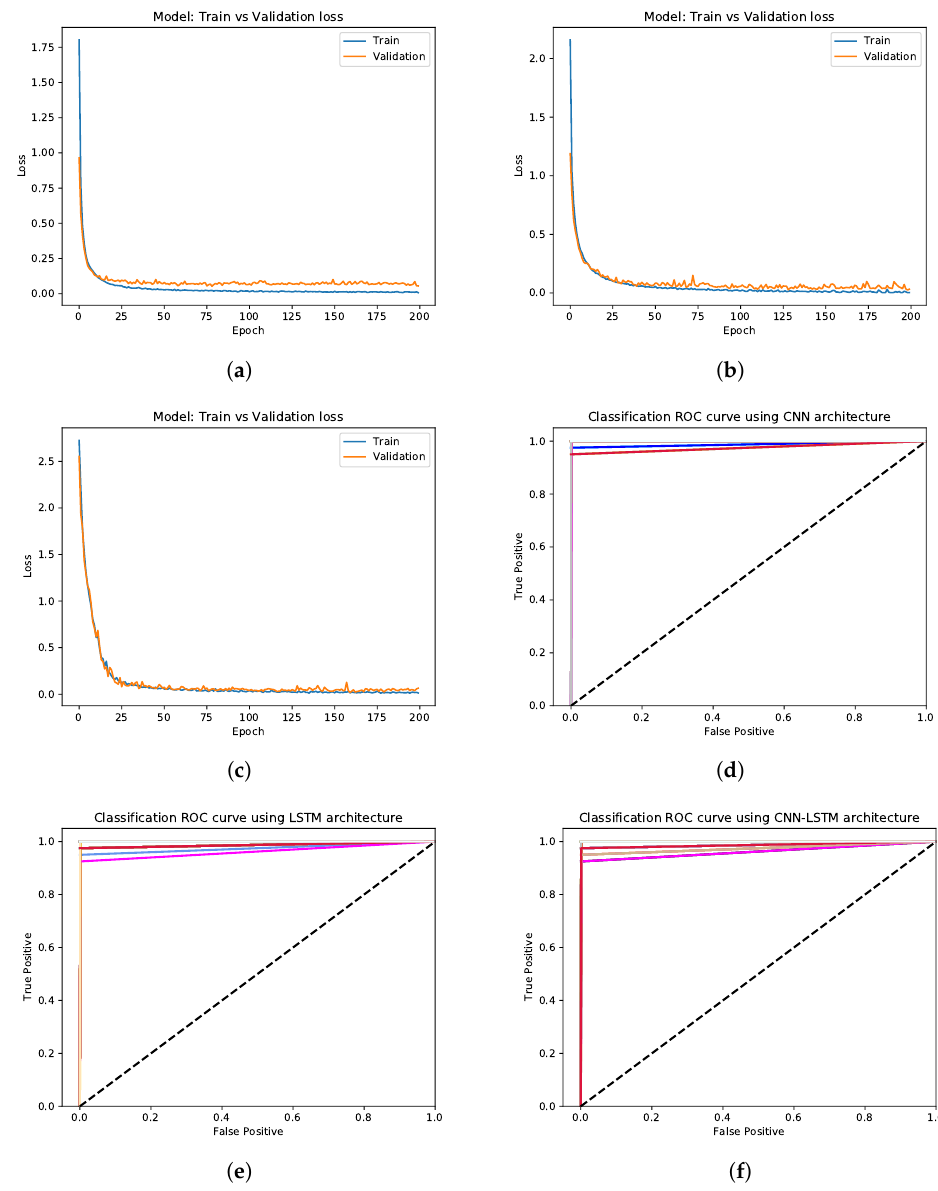
Figure 7. Loss-function and ROC curve for the CNN, LSTM, and CNN-LSTM architectures, the corre- sponding AUC-ROC metric performances are 0.99464, 0.99679, and 0.99500. ( a ) Loss function for the CNN architecture. ( b ) Loss function for the LSTM architecture. ( c ) Loss function for the CNN-LSTM architecture. ( d ) ROC curve for the CNN architecture. ( e ) ROC curve for the LSTM architecture. ( f ) ROC curve for the CNN-LSTM architecture. In ( d – f ), the colors indicate different classes and the diagonal dotted line represents the behavior of a random